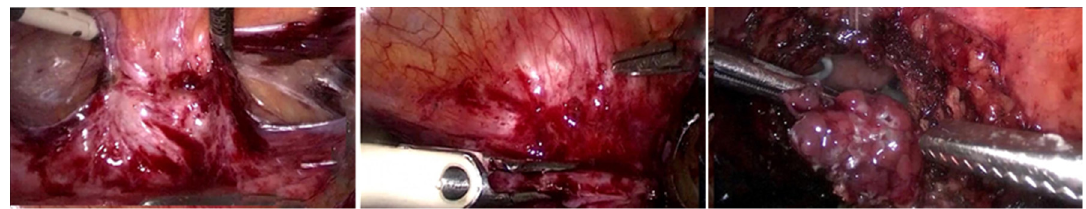
Figure 2. Urinary tract endometriosis—laparoscopic resection of a bladder endometriosis nodule infiltrating the bladder mucosa (personal collection, L.